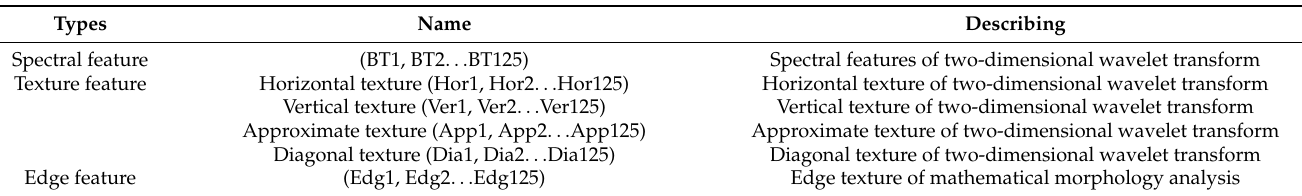
Table 6. List of the spatial texture and transform features for hyperspectral